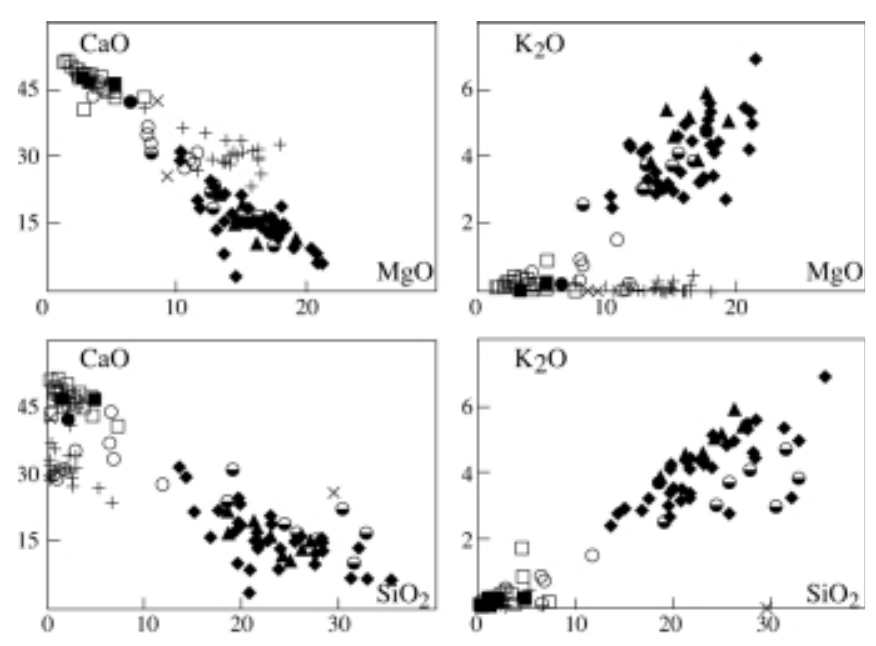
Fig. 7 – CaO and K 2 O vs. MgO and CaO and K 2 O vs. SiO 2 diagrams (wt%) for carbonatites and mica-rich rocks from Araxá. Symbols as in Fig.